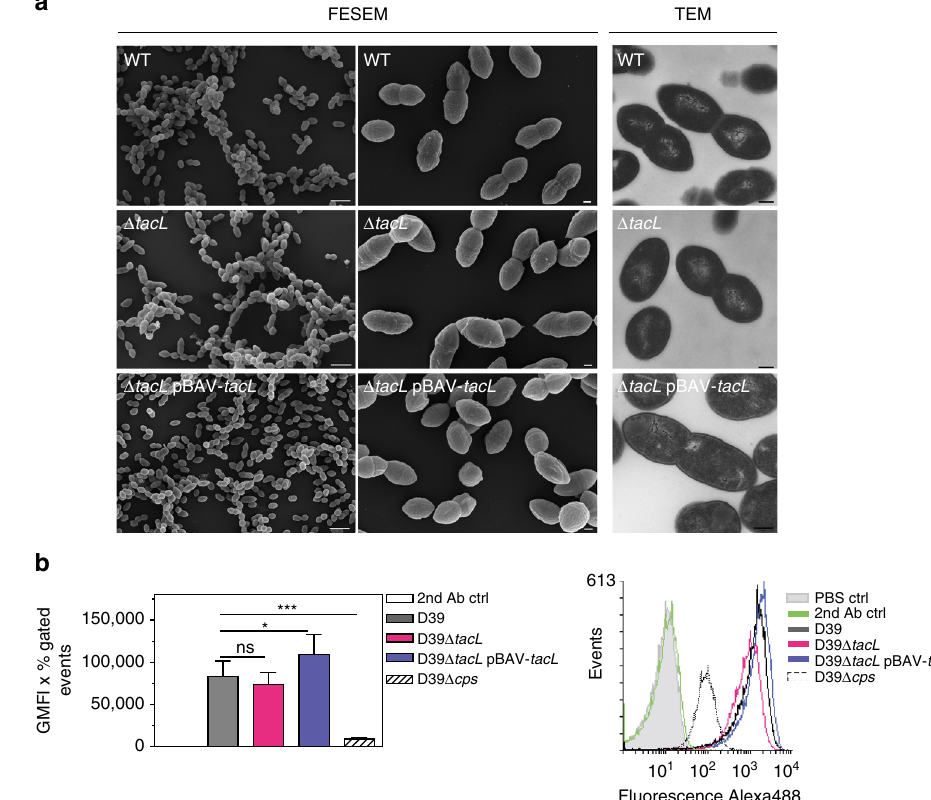
Fig. 3 Analysis of pneumococcal cell morphology and cell division by electron microscopy and quanti fi cation of the capsule content. a FESEM and TEM ultrathin sections revealed no visible differences in the cell morphology and cell division septa morphology between nonencapsulated D39 wild-type (WT), tacL mutant ( Δ tacL ), or complemented mutant ( Δ tacL pBAV- tacL ) grown in THY medium. Scale bars = 2 µ m (FESEM, left panel), 0.2 µ m (FESEM, right panel), 0.2 µ m (TEM). b Flow cytometric analysis of the capsule content. Bacteria were grown in THY medium to A 600 = 0.35 – 0.45, washed and incubated with serum against type 2 capsule followed by a secondary Alexa 488 -labeled antibody. The values are represented as the geometrical mean fl uorescence intensity multiplied with percent-gated events. Results are expressed as means ± s.d. (each experiment was performed at least three times). *** p < 0.001; * p < 0.05; ns not signi fi cant (Student's unpaired t